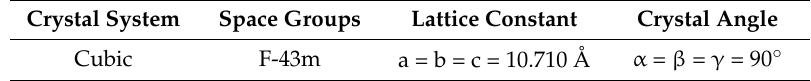
Figure 1. The structure of F-43m bornite in DFT calculation. Table 1. Lattice constants of the bornite structure in DFT calculation (CASTEP module of Materials Studio 6.0 software package, PBE density function, Hubbard + U correction). Crystal System